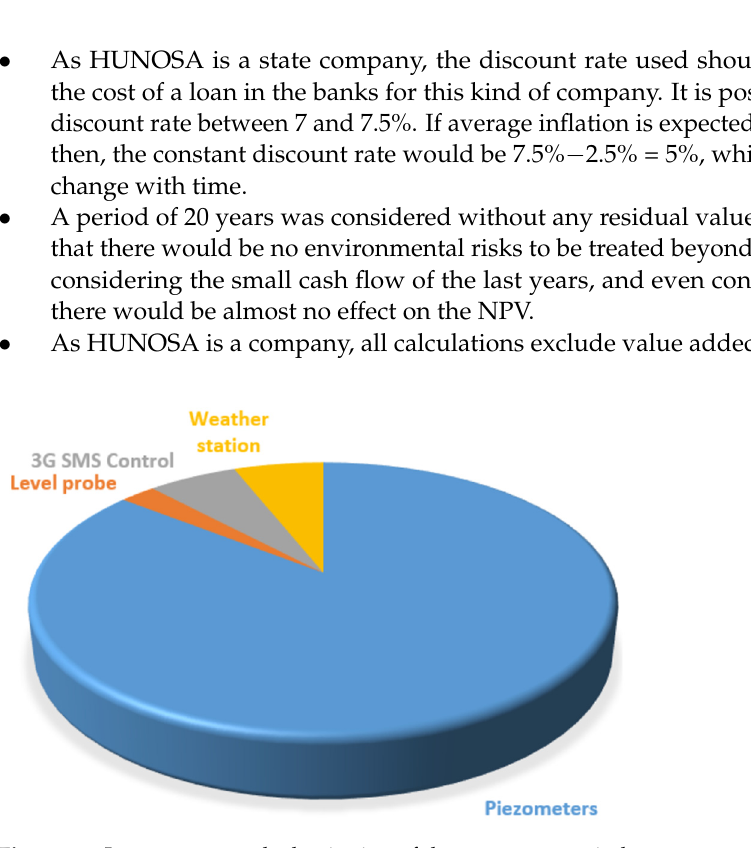
Figure 11. Investments at the beginning of the treatment period.